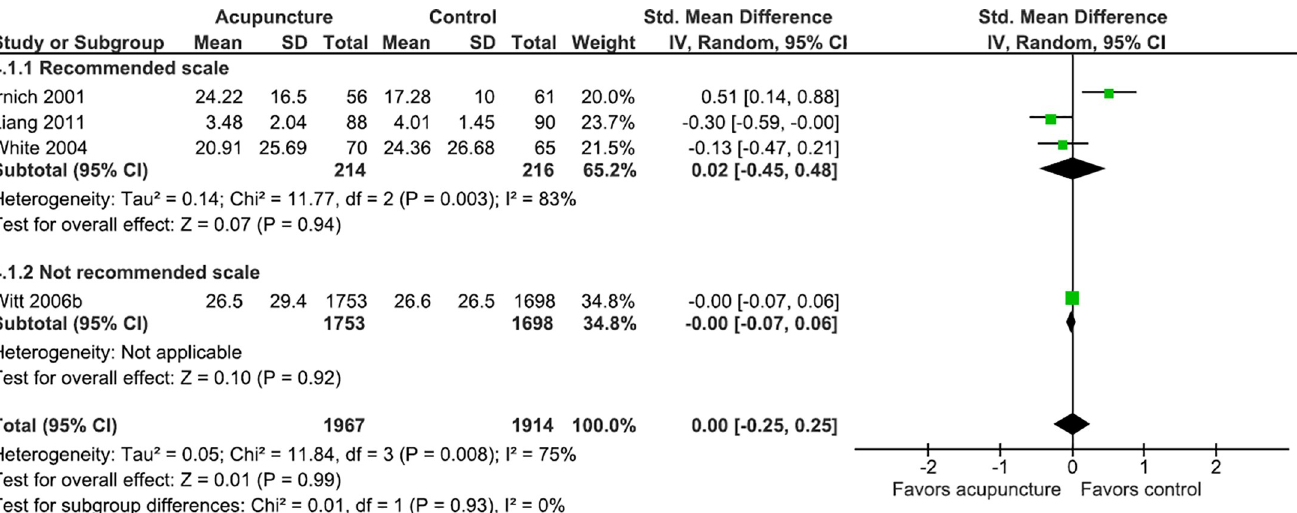
Fig 6. Meta-analysis of the effect of acupuncture in patients with low back pain stratified by the use of recommended scales or not.